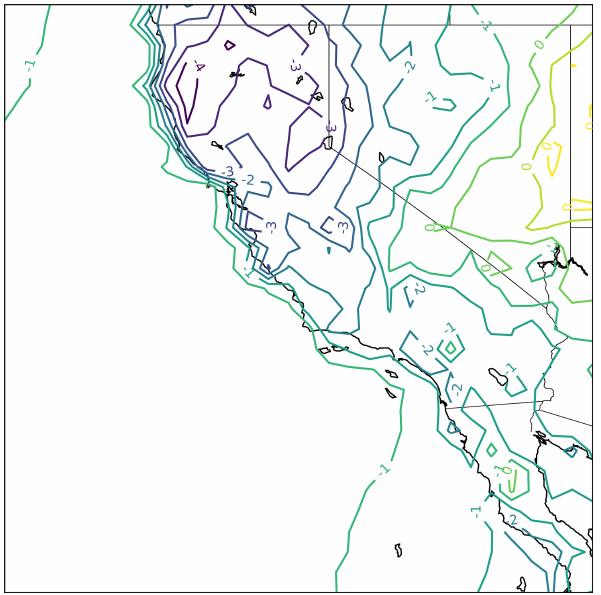
Figure 9. North American Regional Reanalysis 2m air temperature ( ◦ C) difference between cases in which the low-level jet speed ex- ceeds 12ms − 1 and cases in which it is below 7ms − 1 at 01:00PST. Positive values indicate warmer surface temperatures for strong jets.